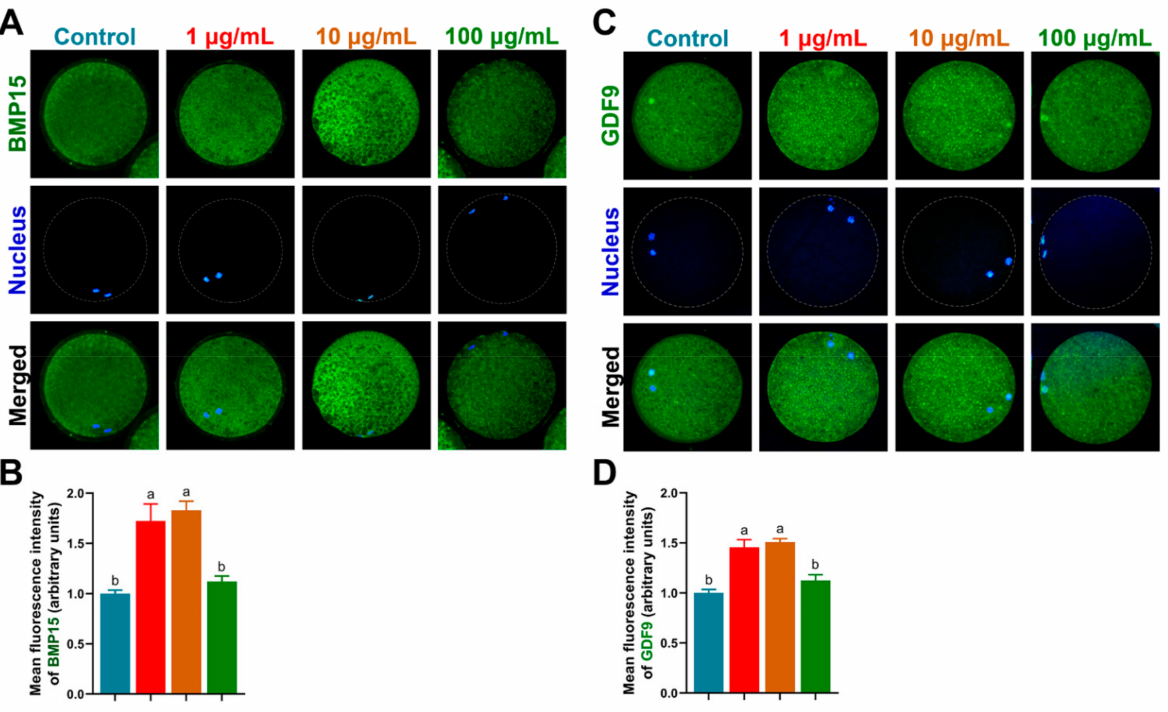
Figure 5. Detection of BMP15 and GDF9 protein levels by immunofluorescence in porcine oocytes. ( A , B ) BMP15 expression in oocytes. ( C , D ) GDF9 expression in oocytes. Bars with different letters denote significant differences ( p < 0.05). Results are shown as the average ± SEM of at least three repeats of independent